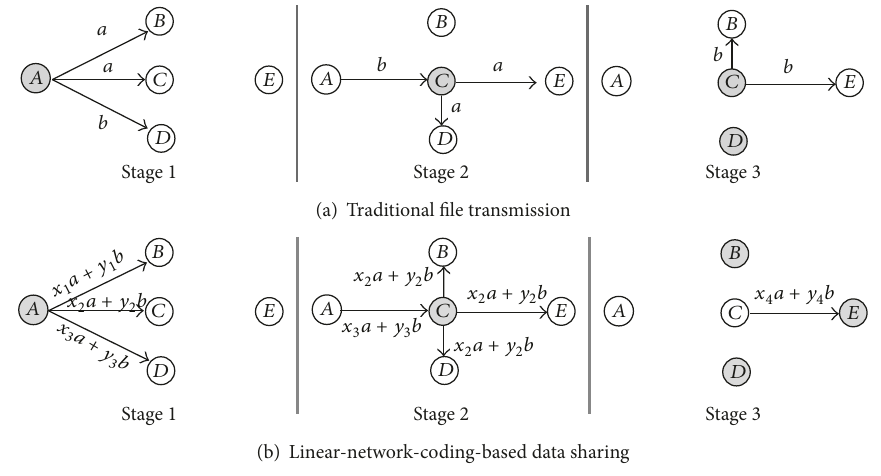
Figure 1: Data sharing in different